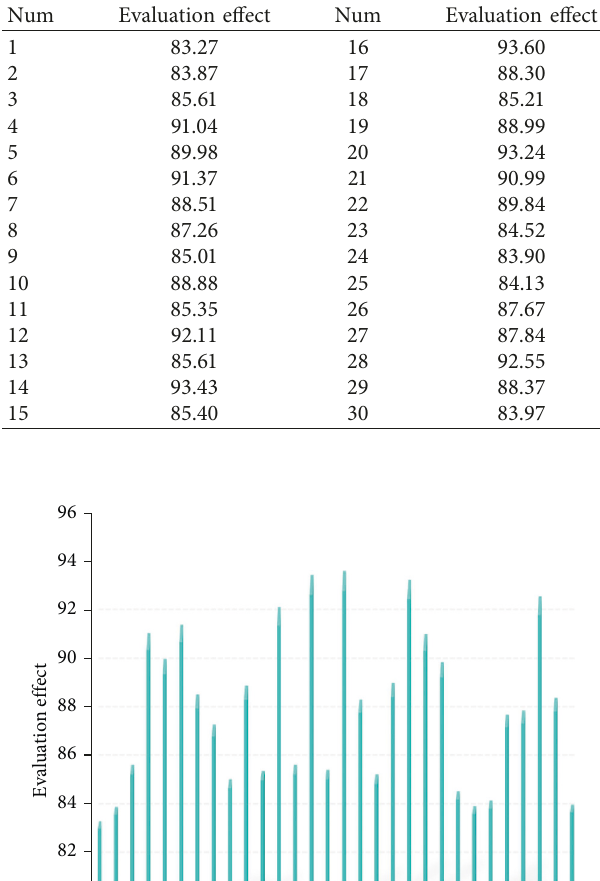
Figure 9: The functional modules of the evaluation system of college English teaching process based on the Rasch model. Table 1: Evaluation of the effect of the evaluation system of college English teaching process based on the Rasch model.